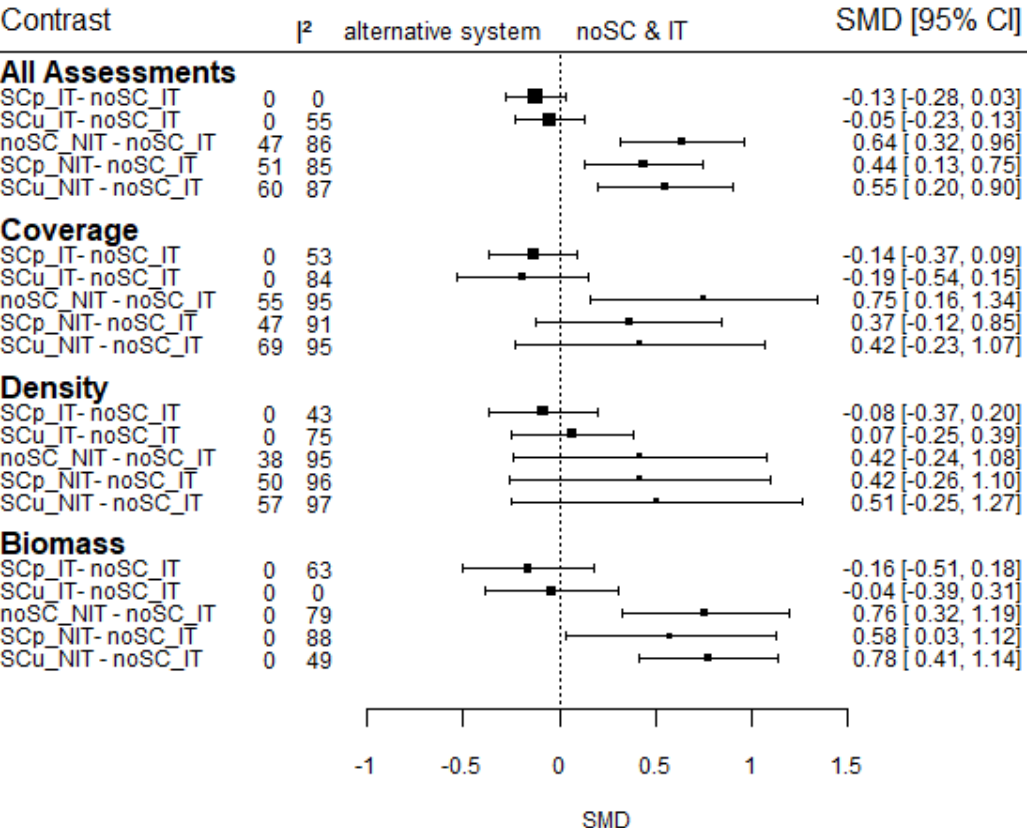
Figure 7. Forest plot showing the comparison of the effects of all interactions of the factors subsidiary crops (SCu — under-sown subsidiary crops, SCp — subsidiary crops sown post-harvest, noSC — no cultivation of subsidiary crops) and tillage (IT — inversion tillage, NT — non-inversion tillage) on the weed abundance compared to the effect of the conventional system (no subsidiary crops and IT/ noSC_IT) for all subsets (coverage, biomass, and density assessments) and the whole datasets in the second crop period. Effect sizes are given as standardized mean differences (SMD). The zero line is the effect of the conventional system on the weed abundance. All negative effects sizes have a lesser weed abundance than the conventional system and vice versa. The 95%-confidence interval for I² is given in %.